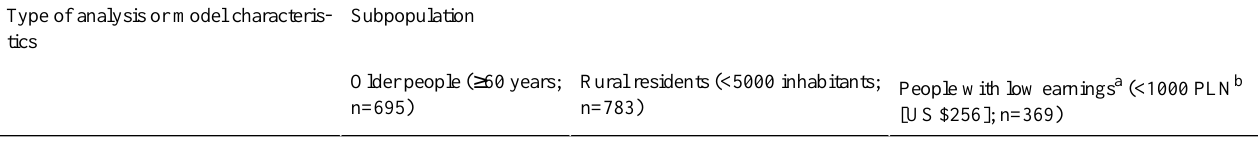
Table 5. Knowledge about dietary supplements and the model performance in subpopulations. SubpopulationType of analysis or model